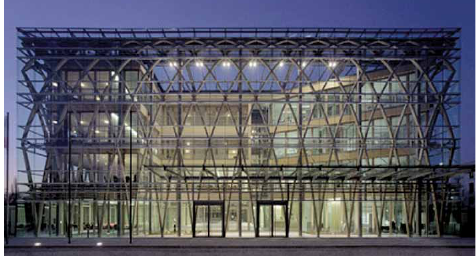
37 pav. Haeslio „Devynių tiltų“ golfo klubas, Pietų Korėja, archit. S. Banas, 2010 m. Fig. 37. Haesley “Nine Bridges” golf clubhouse, South Corea, 39 pav. Medžio ir metalo konstrukcijų perdenginys Šiaulių archit. S. Ban, 2010 sporto arenoje, archit. biuras „E. Miliūno studija“, 2007 m. Fig. 39. Span construction from wood and metal, sport arena in Šiauliai, archit. office “E. Miliūno studija”, 2007